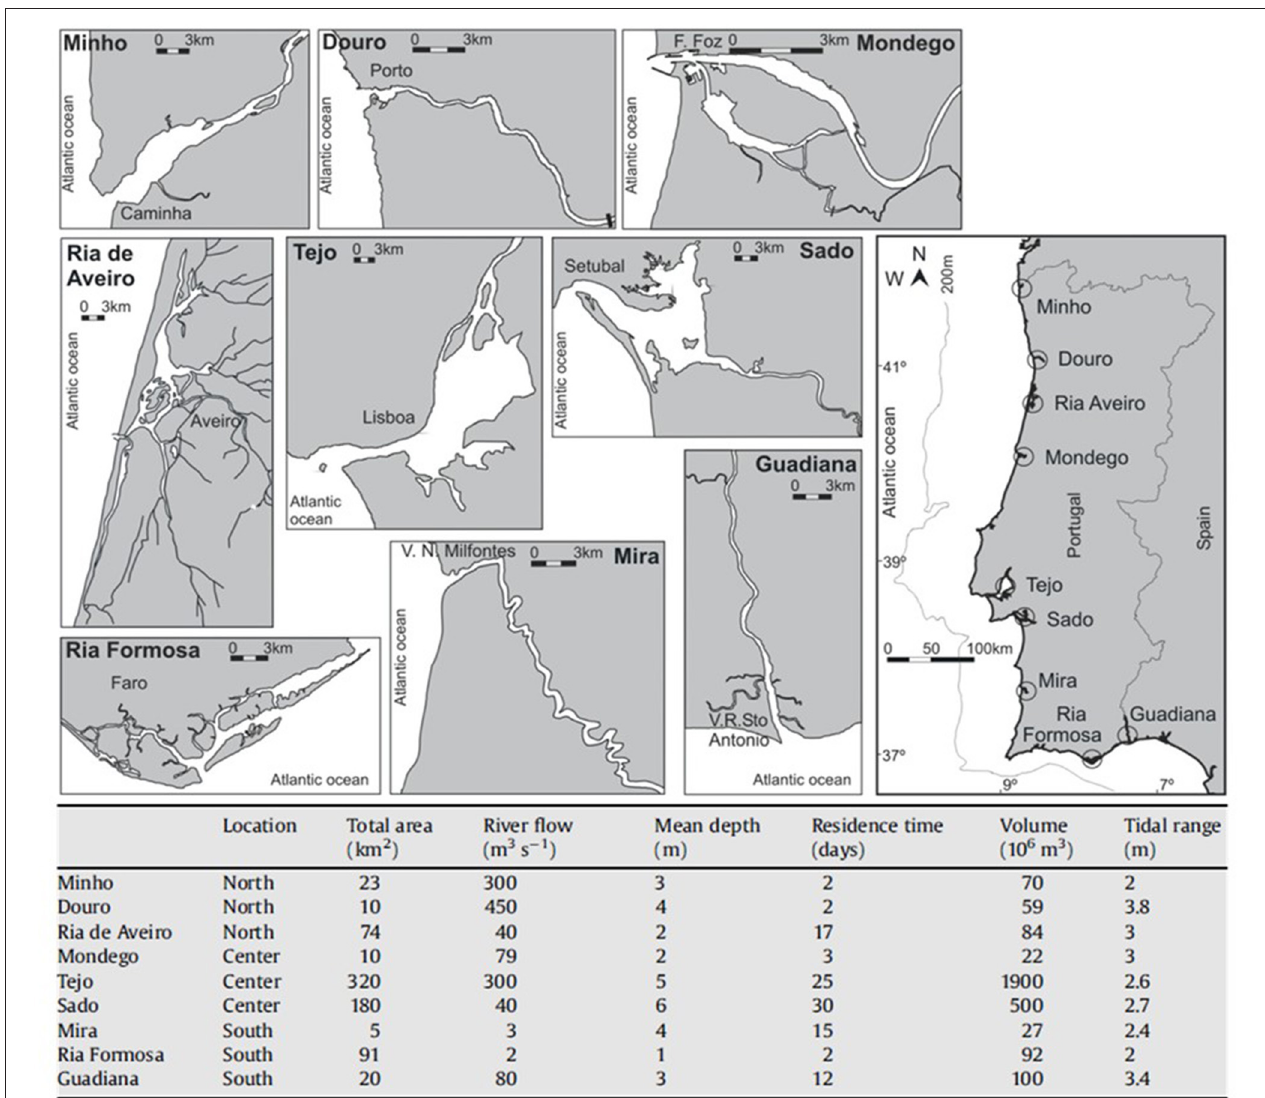
FIGURE 1 | Estuarine systems sampled in the Portuguese coast and their main geomorphologic and hydrologic characteristics.